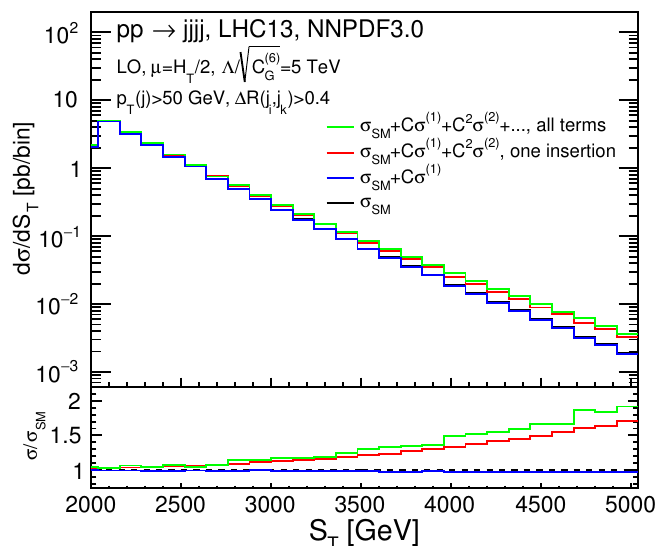
Figure 3 . Comparison between the contributions of order O (1 = (cid:3) 2 ) (interference), O (1 = (cid:3) 4 ) and higher for the production of four partonic jets at LHC13.